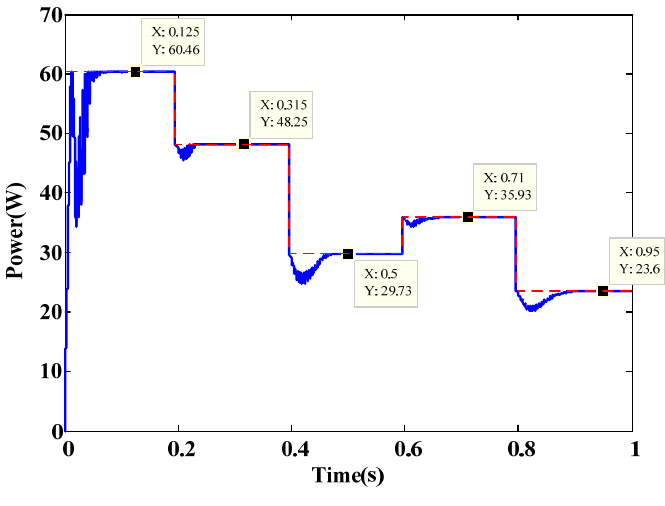
Figure 30. Simulation results for Algorithm